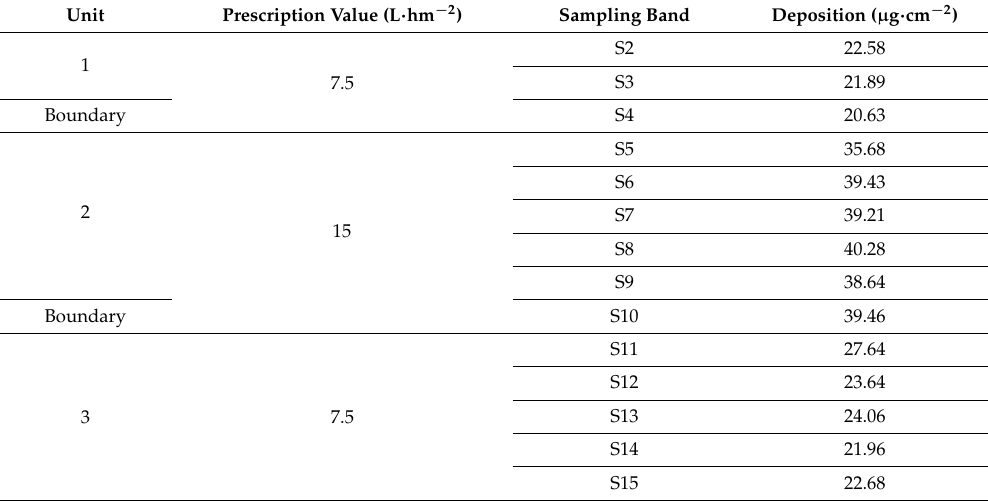
Table 5. Droplet deposition at the boundary of operational unit.